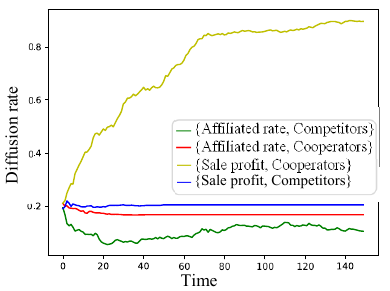
Figure 10. Results in scale free network.